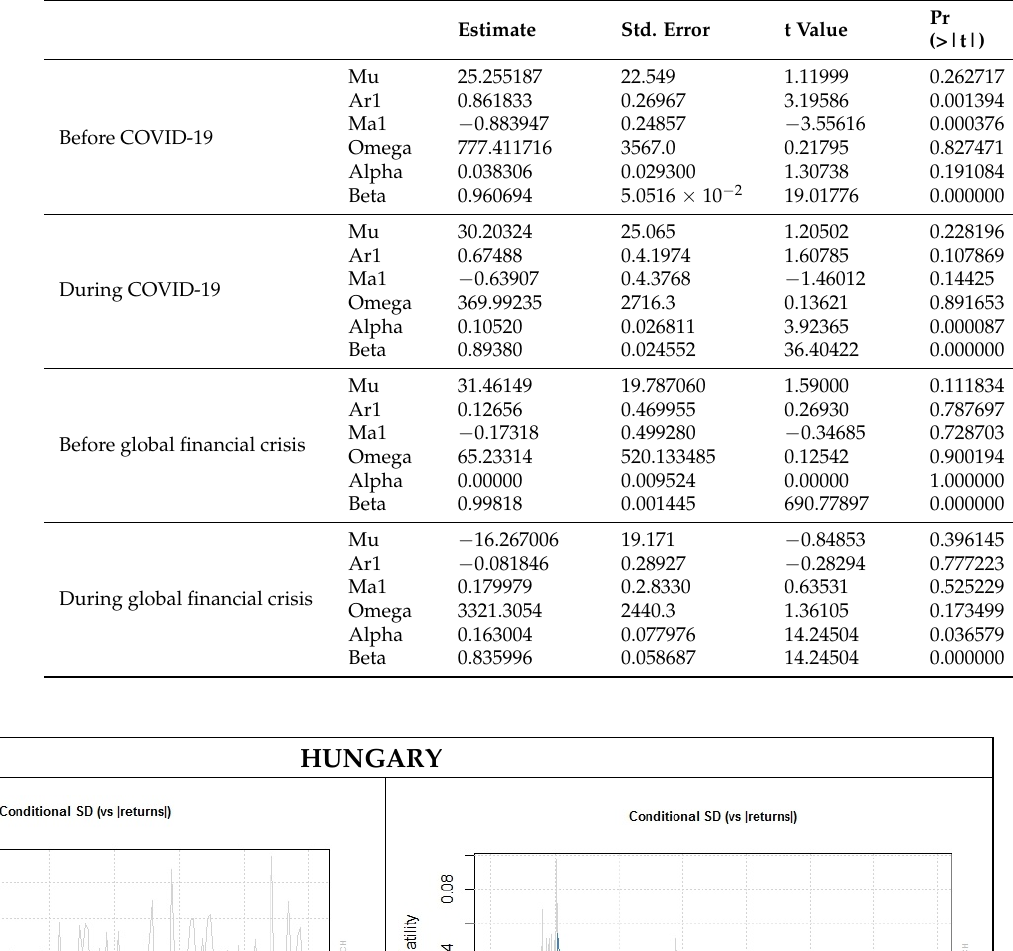
Table 9. GARCH (1,1) Parameters of BUX.